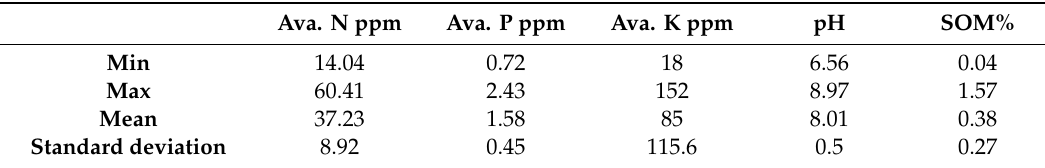
Table 3. Statistical parameters of soil properties (N, P, K, pH, and soil organic matter (SOM)). Ava. N ppm